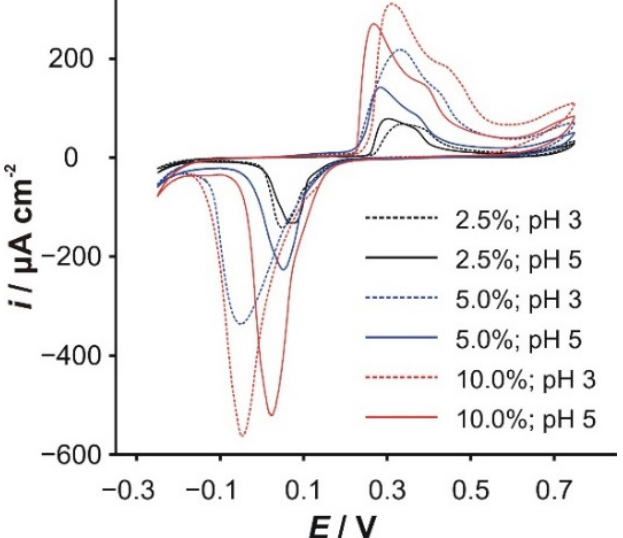
Figure 1. Cyclic voltammograms of the CPEs, modified with various amount of the material, rec- orded at the different pH values (0.1 M acetate